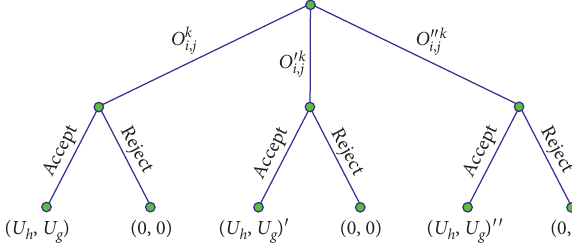
Figure 3: Reverse auction process.